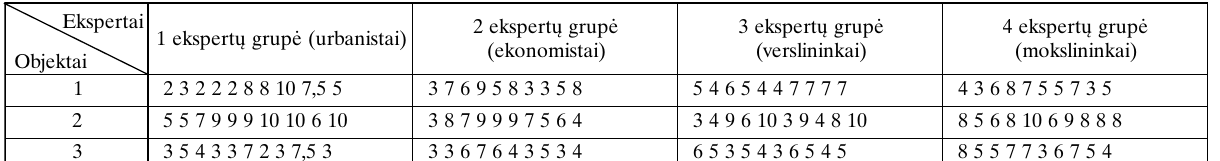
ėpurgųtrepske2 )iatsimonoke(